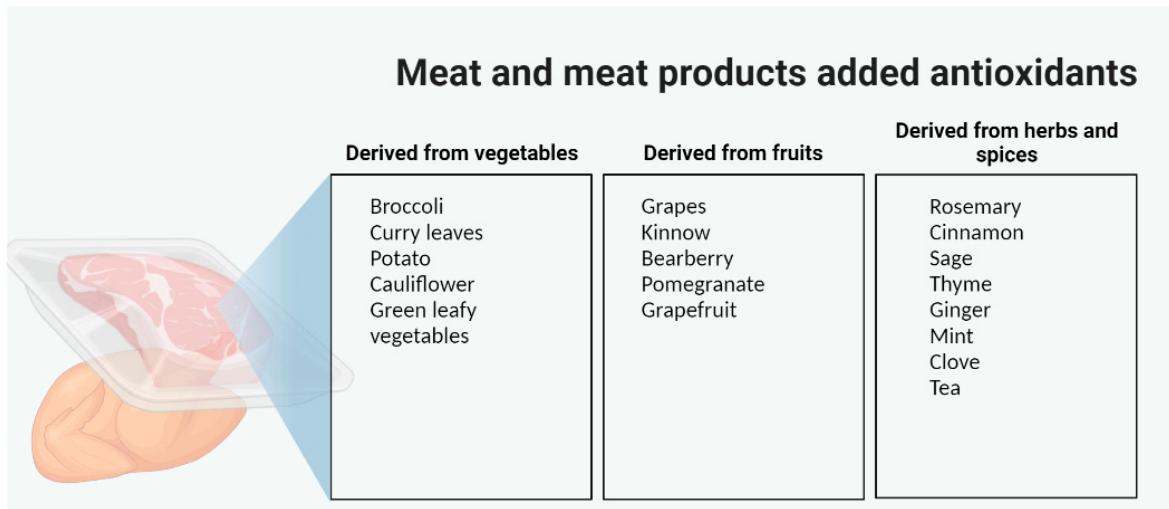
Figure 4. The main categories of natural antioxidants tested in meat and meat products (illustration made via www.BioRender.com, accessed on 9 March 2023).